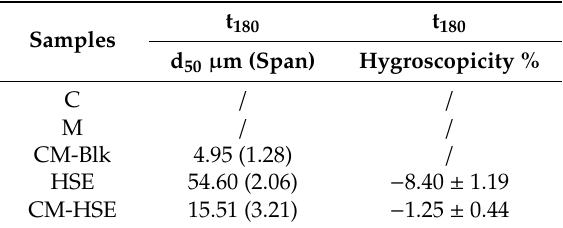
Figure 6. Comparison of dimensional analysis of CM-HSE at t 0 ( a ) and after six months of storage t 180 days ( b) . Table 4. Dimensional distribution (d 50 ) of raw materials and spray-dried systems, and hygroscopicity after six months storage